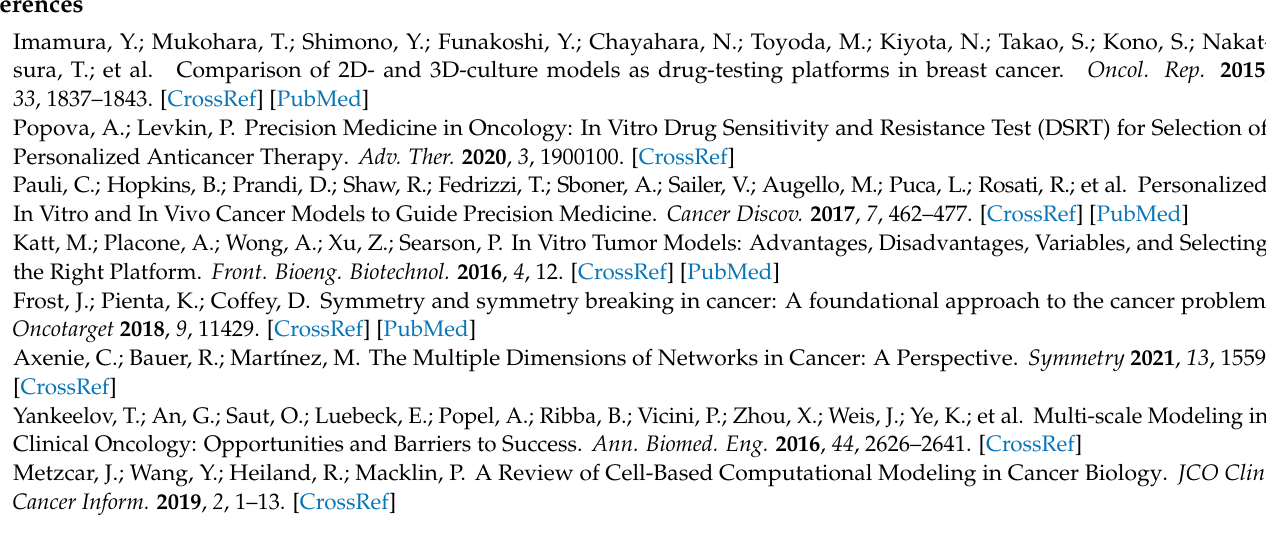
Figure S8: Heat-maps of the absolute error of the simulation results for HCT-116 and MDA-MB-231 under control conditions, Figure S9: Box plots of the in silico model results for the HCT-116 cell line, Figure S10: Box plots of the in silico model results for the MDA-MB-231 cell line, Figure S11: Box plots of the simulation results of the normalised apoptosis probability ratio to the corresponding normalised division probability ratio for HCT-116 and MDA-MB-231, Table S1: HCT-116 cell line apoptosis and division probabilities as predicted in silico, Table S2: MDA-MB-231 cell line apoptosis and division probabilities as predicted in silico, Table S3: HCT-116 cell line survival percentage as quantified in silico, Table S4: MDA-MB-231 cell line survival percentage as quantified in